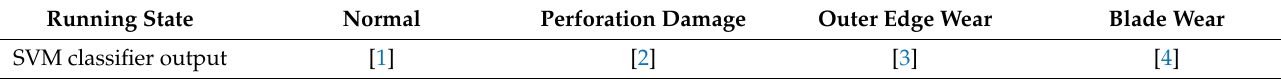
Table 1. SVM output for each state of slurry pump.